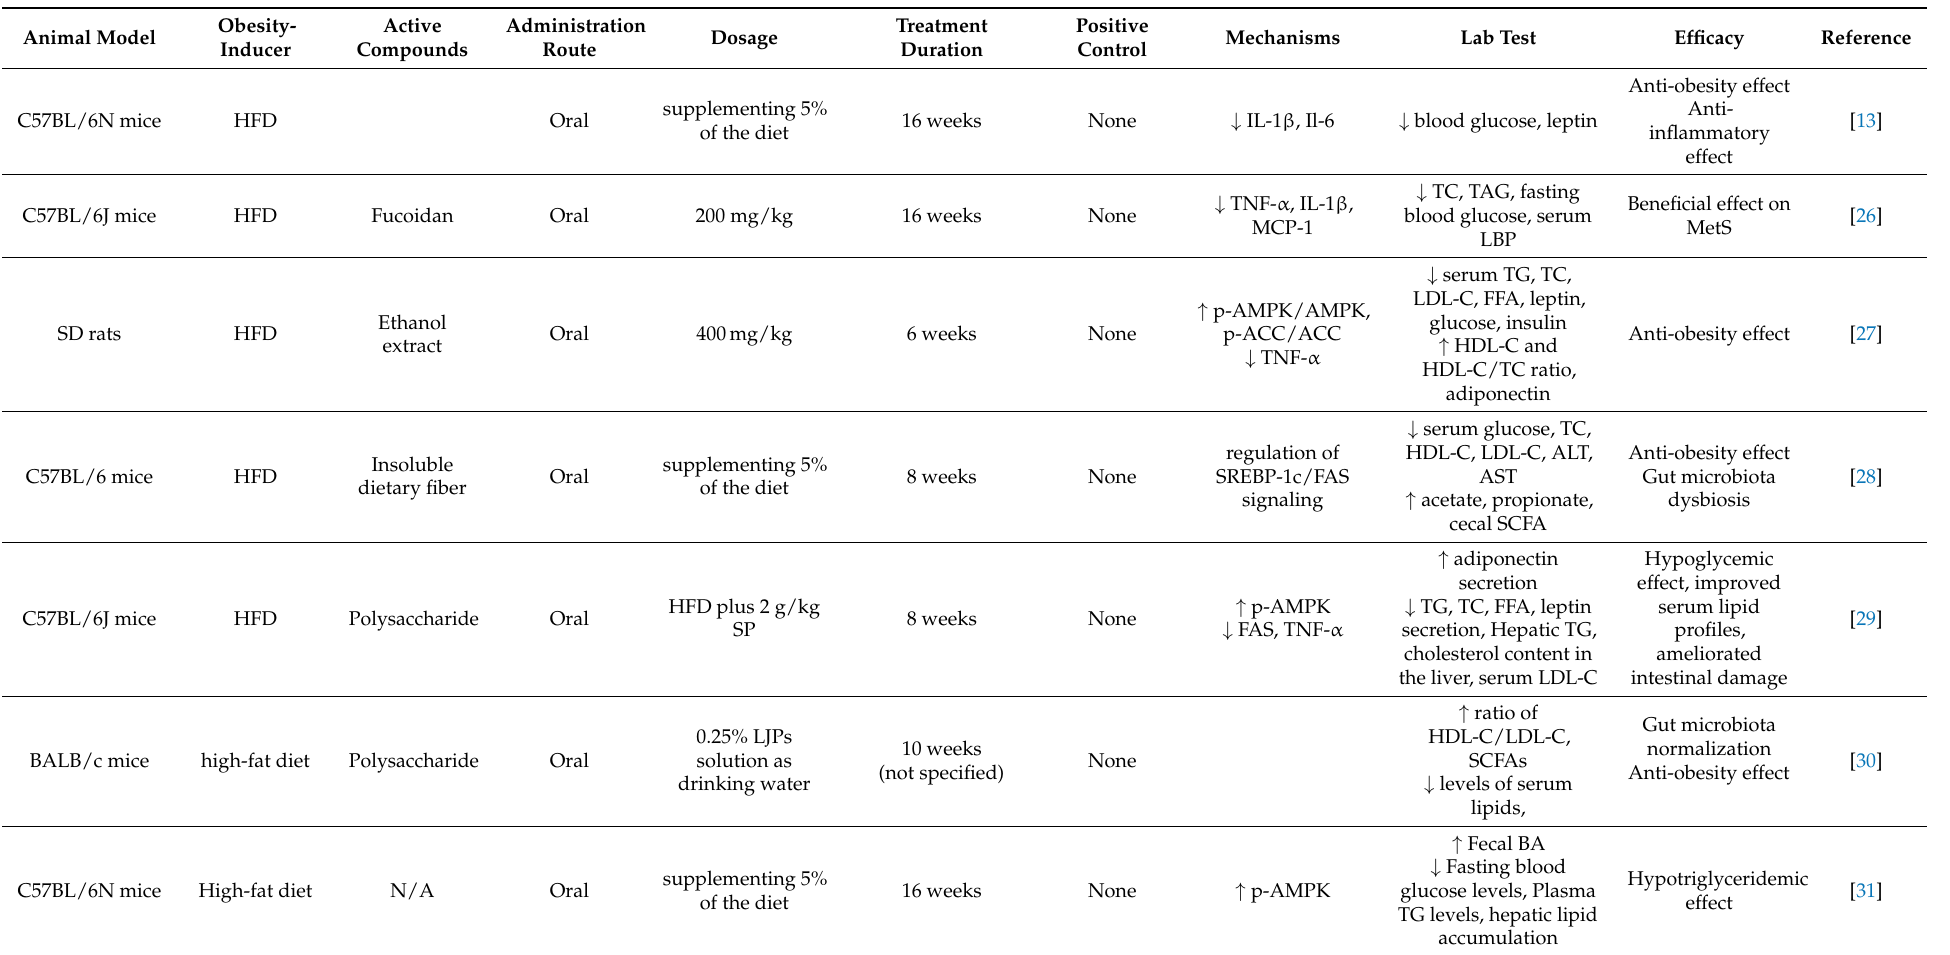
Table 2. An overview of the included in vivo studies on the efficacy of LJP on